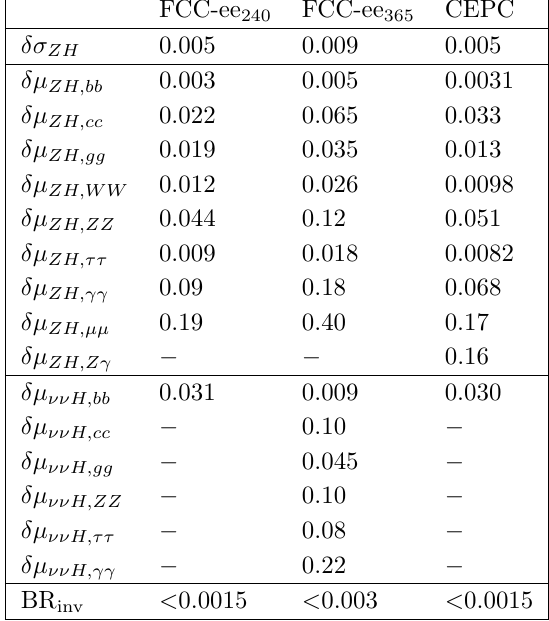
Table 20 . Inputs used for CEPC and FCC-ee projections. All uncertainties are given as fractional 68% CL intervals and are taken to be symmetric. The upper limits are given at 68% CL. A dash indicates the absence of a projection for the corresponding